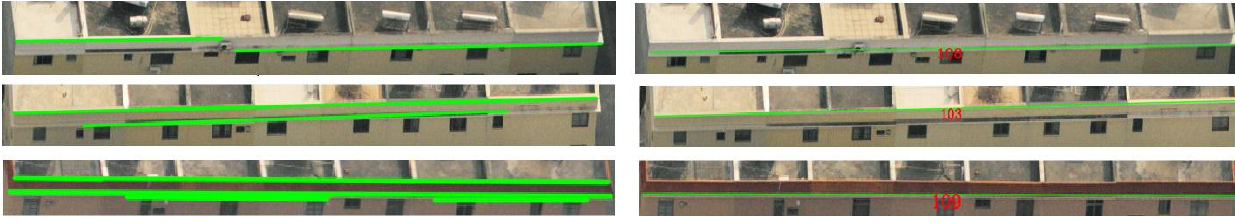
Figure 15. Non-unique locations of wall–roof edges because of the selection